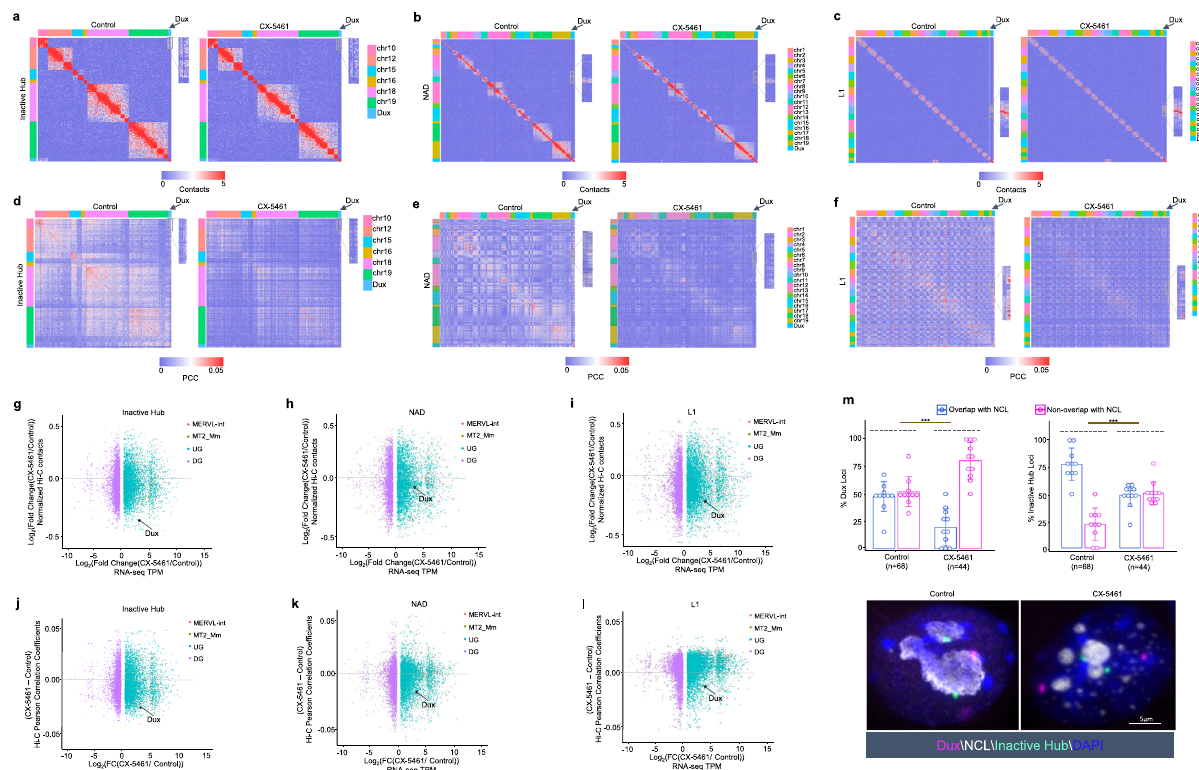
Fig. 6 rRNA biogenesis defect drove 3D chromatin structure reorganization of PNH region towards the 2C-like state. a Hi-C contact maps of Inactive Hub and 1.5 Mb genomic regions around Dux at 150 kb resolution. GEO accession code GSE166041. b Hi-C contact maps of NAD and 1.5 Mb genomic regions around Dux at 150 kb resolution. GEO accession code GSE166041. c Hi-C contact maps of L1 and 1.5 Mb genomic regions around Dux at 150 kb resolution. The zoomed-in regions aim to demonstrate the change of Hi-C contacts between Dux and chromosome 10 in control mES cells and CX-5461 treated mES cells. GEO accession code GSE166041. d Hi-C pearson correlation coef fi cient (PCC) heat maps of Inactive Hub and 1.5 Mb genomic regions around Dux at 150 kb resolution. GEO accession code GSE166041. e Hi-C pearson correlation heat maps of NAD and 1.5 Mb genomic regions around Dux at 150 kb resolution. GEO accession code GSE166041. f Hi-C pearson correlation heat maps of L1 and 1.5 Mb genomic regions around Dux at 150 kb resolution. The zoomed-in regions aim to demonstrate the change of Hi-C PCC between Dux and chromosome 10 in control mES cells and CX-5461 treated mES cells. GEO accession code GSE166041. g Scatter plot demonstrates the log 2 (fold change) of Hi-C contacts between Inactive Hub and different types of genes in control and CX-5461 treated mES cells. GEO accession code GSE166041. h Scatter plot demonstrates the log 2 (fold change) of Hi-C contacts between